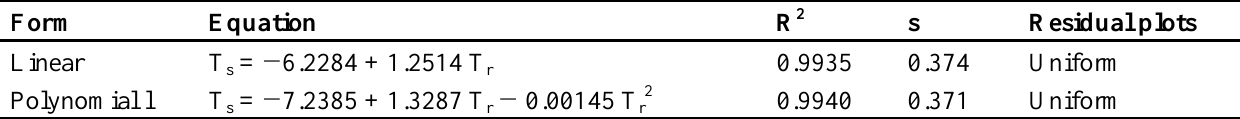
Table 3. The calibration equations and statistics of the SENTRON SI-10A infrared thermocouple within the narrower measurement ranged from 20  C to 35  C.